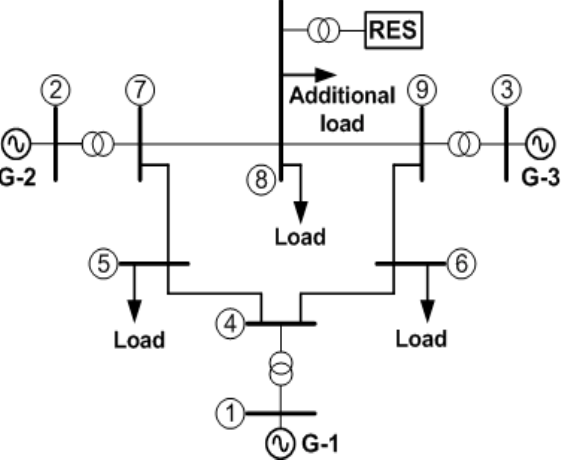
Figure 7. WSCC 3-machine 9-bus system connected with RES at bus 8.